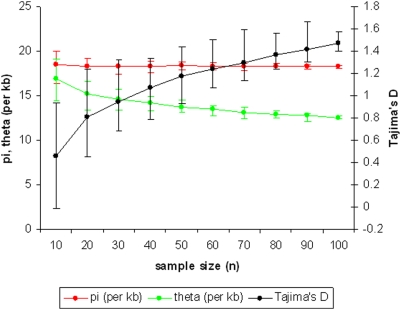
Sample size optimisation for Tajima's D test assessed using a large sample of ama1 gene sequences from a Gambian P. falciparum population.100 random samples of each size (n) were taken from a set of 114 ama1 sequences covering the region encoding the ectodomain of the protein (nucleotides 442–1743). The median values and 95% confidence limits (3rd and 97th centile values of 100 estimates) of π, θ, and Tajima's D indices were calculated for each sample size.